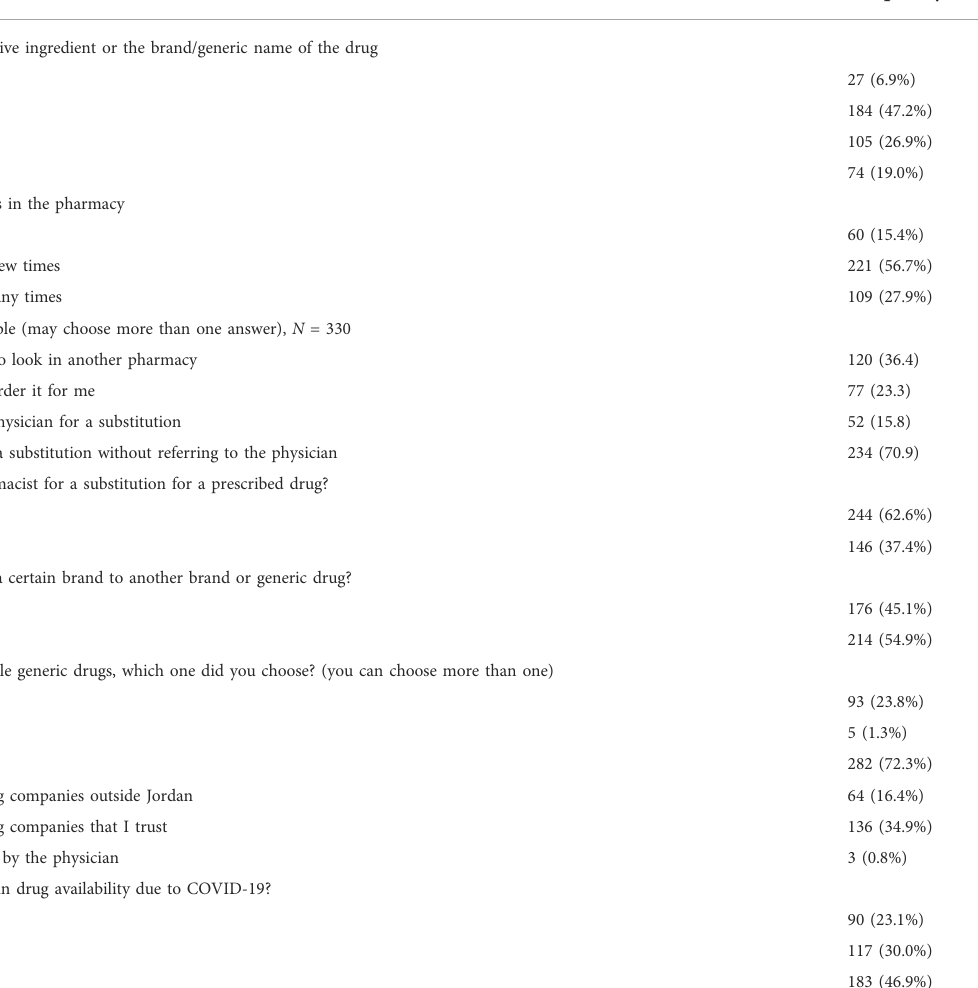
TABLE 2 Participant ’ s past experiences towards generic switching, N =